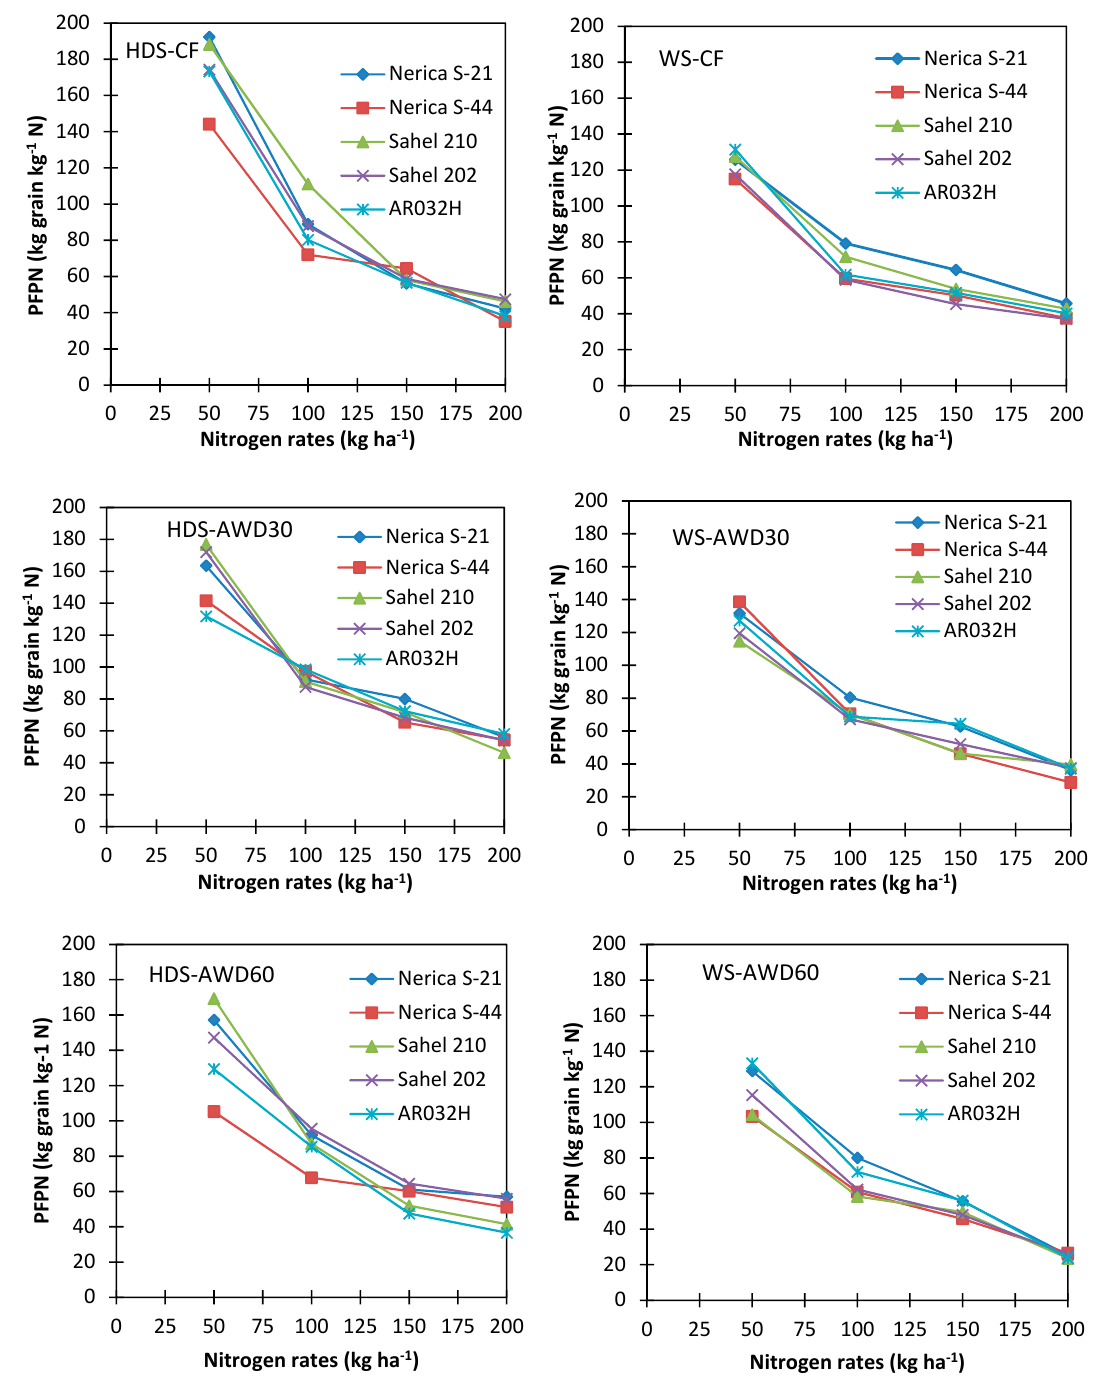
Figure 7. Variation in partial factor productivity of nitrogen (PFPN) of five rice genotypes as function of applied nitrogen fertilizer rates.